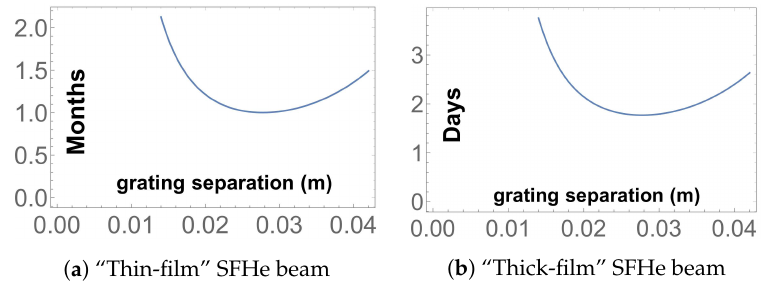
Figure 7. Representative MAGE sensitivity estimates vs. grating separation for beam options described in text, with 0.5 µ m-thick gratings of 100nm pitch, assuming 10% contrast and that statistical uncertainties dominate over systematics; shown is beam time required for 5 σ determination of the sign of ¯ g (i.e., δ ¯ g / g = 0.4). 8